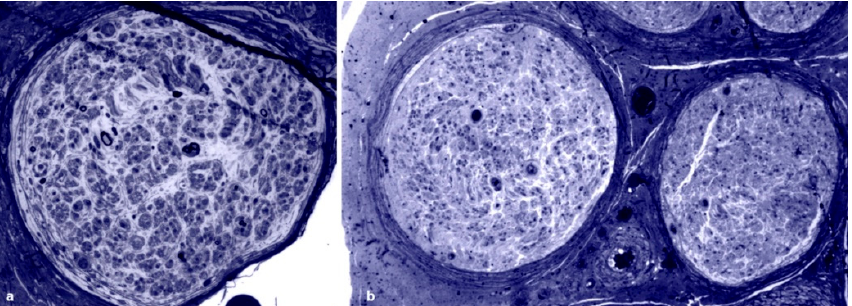
Figure 1. Sural nerve biopsies from hATTR patients. Semithin sections are stained with toluidine blue. ( a ) A biopsy from a 63-year-old Val30Met patient showing a marked loss of myelinated fibers. ( b ) A biopsy from a 74-year-old Phe64Leu patient with complete loss of myelinated